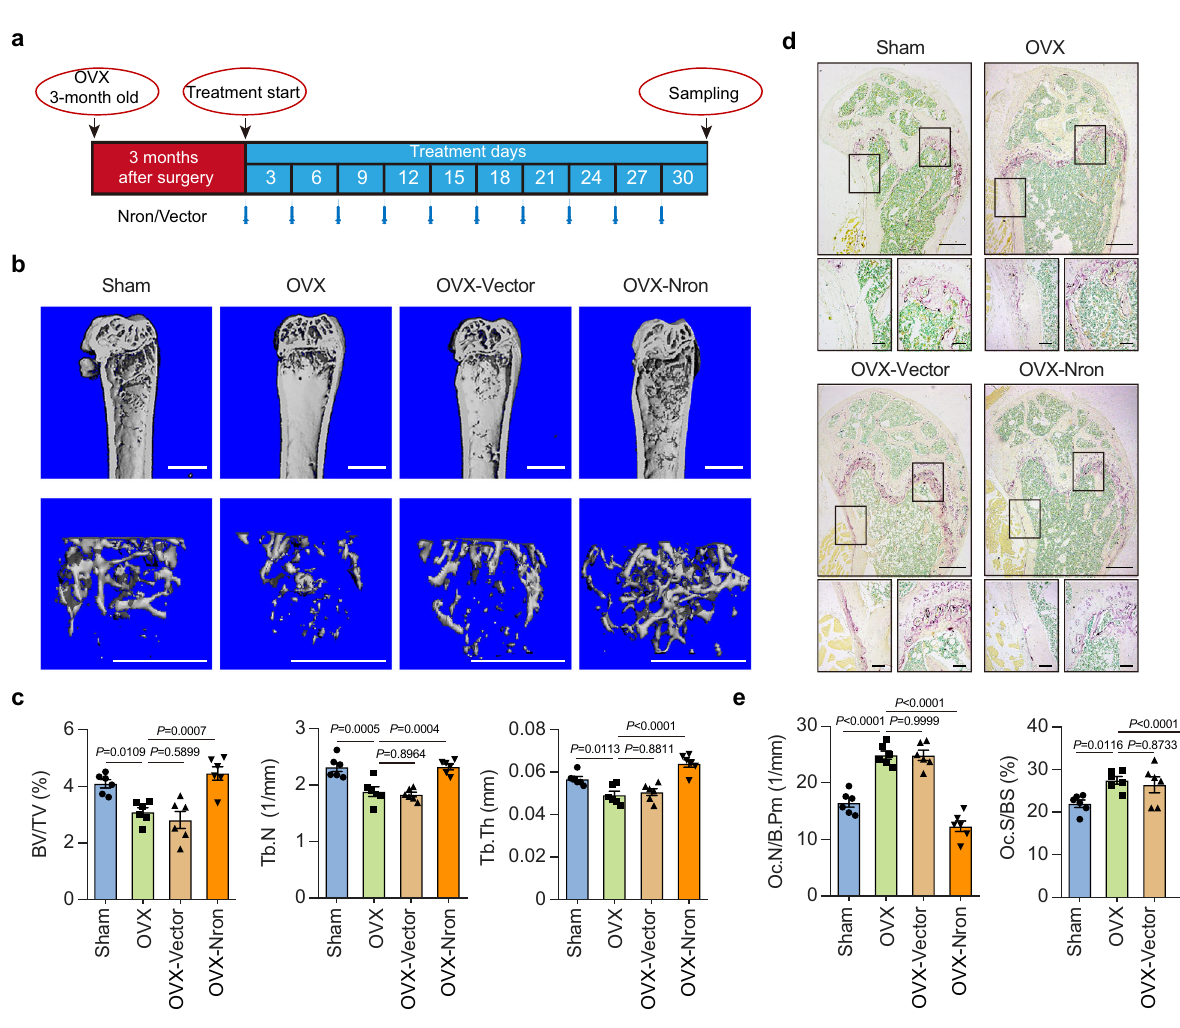
Fig. 5 Osteoclastic delivery of Nron inhibits bone resorption of OVX mice. a Schematic diagram illustrating the experimental design of Nron treatment in OVX mice. b Representative μ CT images showing the 3D bone structures of mice femurs from Sham, OVX, OVX-Vector, and OVX-Nron group, (similar results were obtained in all mice, n = 6/group). Scale bar: 1 mm (all panels). c μ CT measurements of BV/TV, Tb.N, and Tb.Th in femurs from Sham, OVX, OVX-Vector, and OVX-Nron group, ( n = 6/group). d Representative TRAP staining images of mice femurs from Sham, OVX, OVX-Vector, and OVX-Nron group, (similar results were obtained in all mice, n = 6/group). Scale bar: 500 μ m (upper panels); 100 μ m (lower panels). e Quanti fi cation of